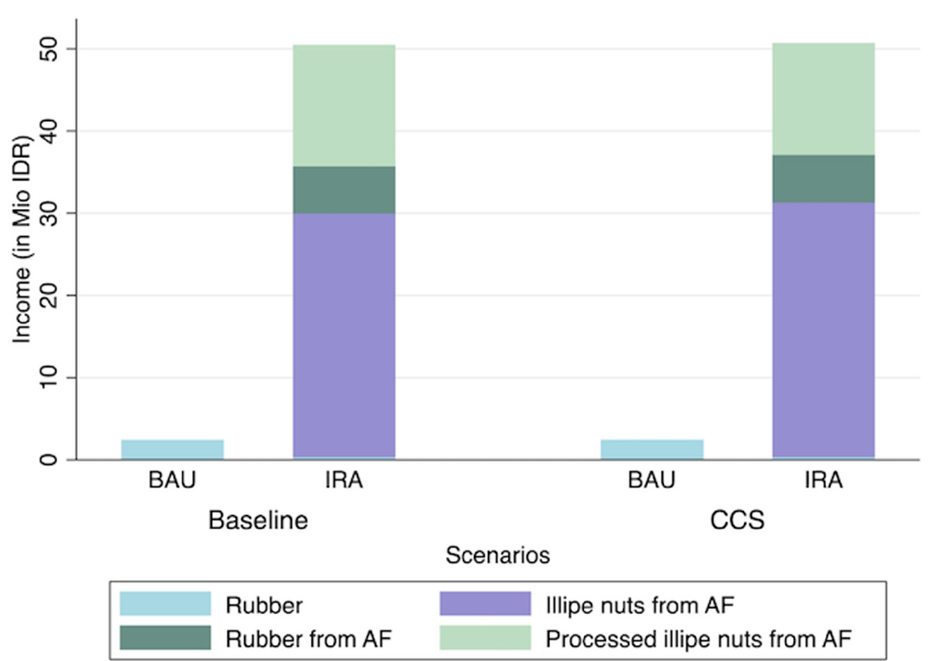
Figure A6. Simulation results: generated cash income in the baseline and climate change scenario.